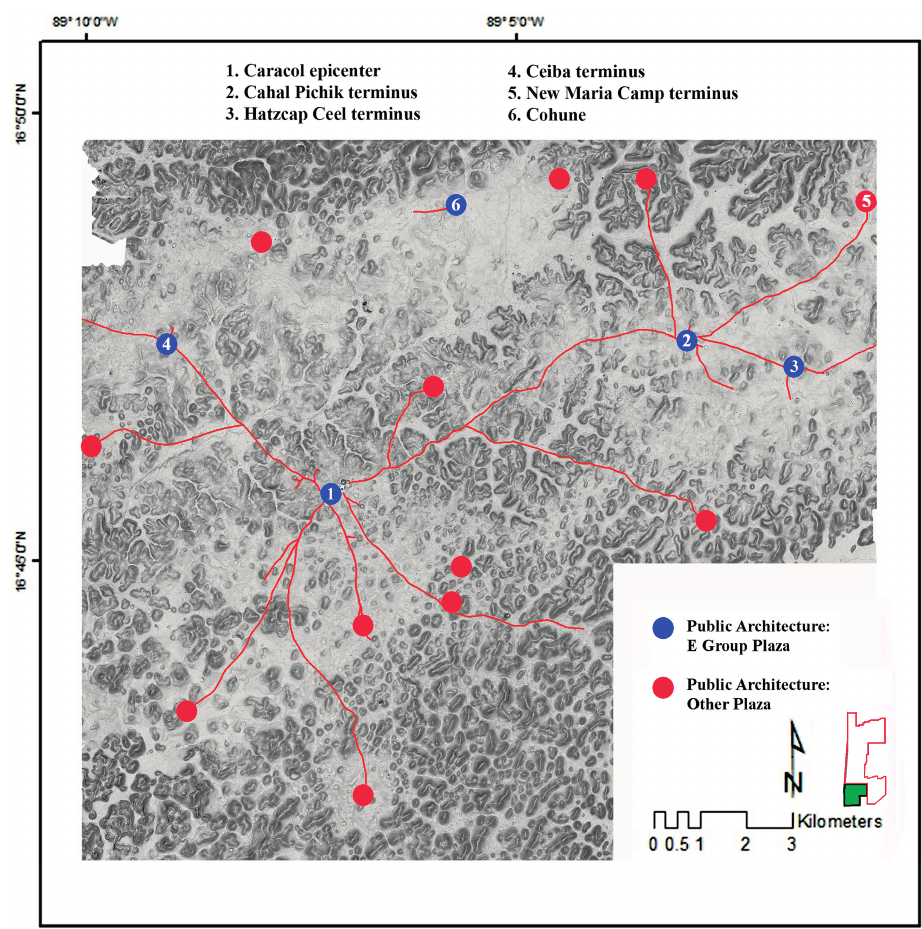
Figure 2. The 2009 LiDAR DEM of the Vaca Plateau with an overlay of Caracol’s causeways and the distribution of the site’s public plazas and architecture. The area between this public space is infilled with agricultural terraces and Maya residential